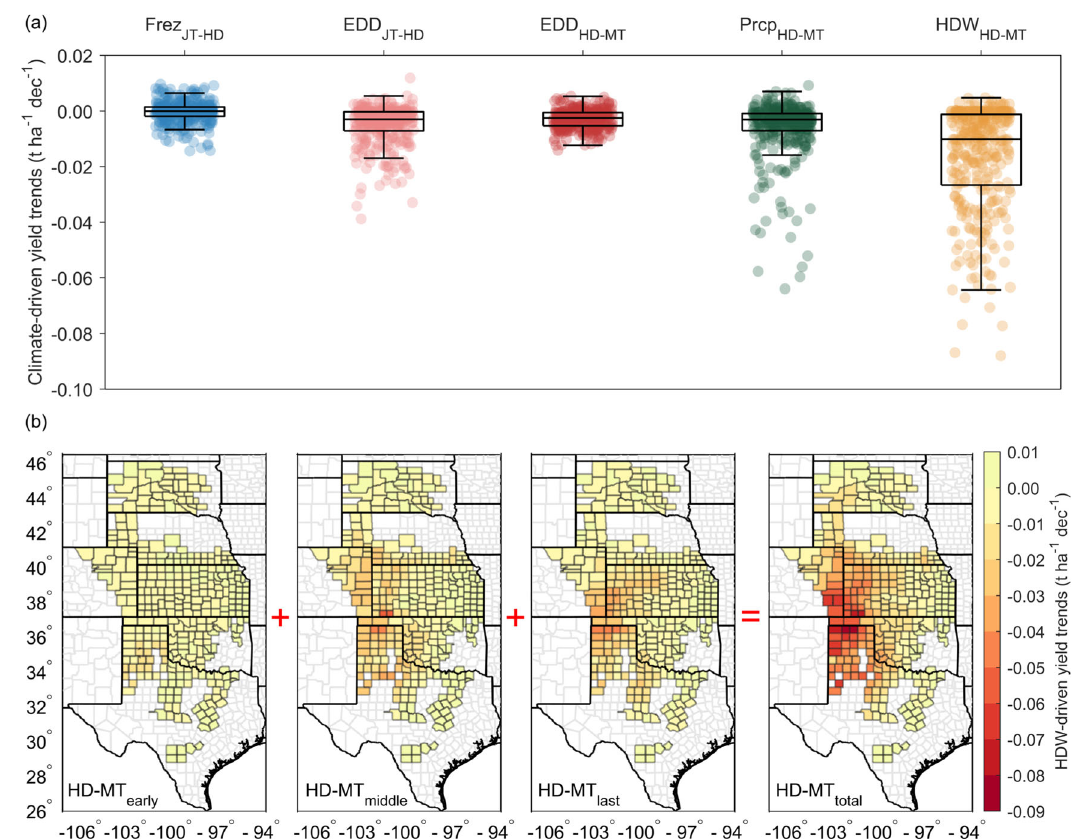
Fig. 3 | Climate contributions to yield trends from 1982 to 2020. a Yield trends associated with freezing days (Frez) and extreme degree days (EDD) during the jointing(JT)toheading(HD)stages,andwiththeEDD,precipitation(Prcp),andhot- dry-windy (HDW) during the heading (HD) to maturity (MT) stages. Box plots